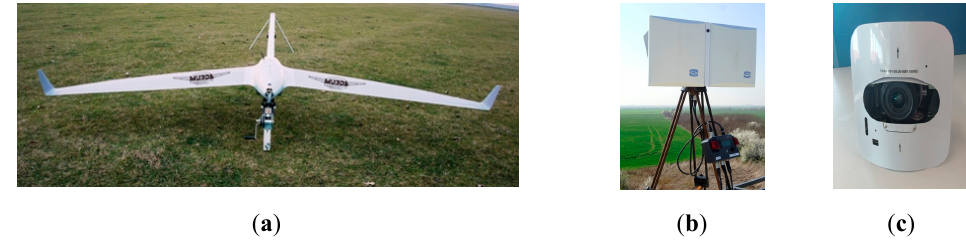
Figure 1. System components: ( a ) UAV fixed wing; ( b ) ground terminal, and ( c ) payload photo.